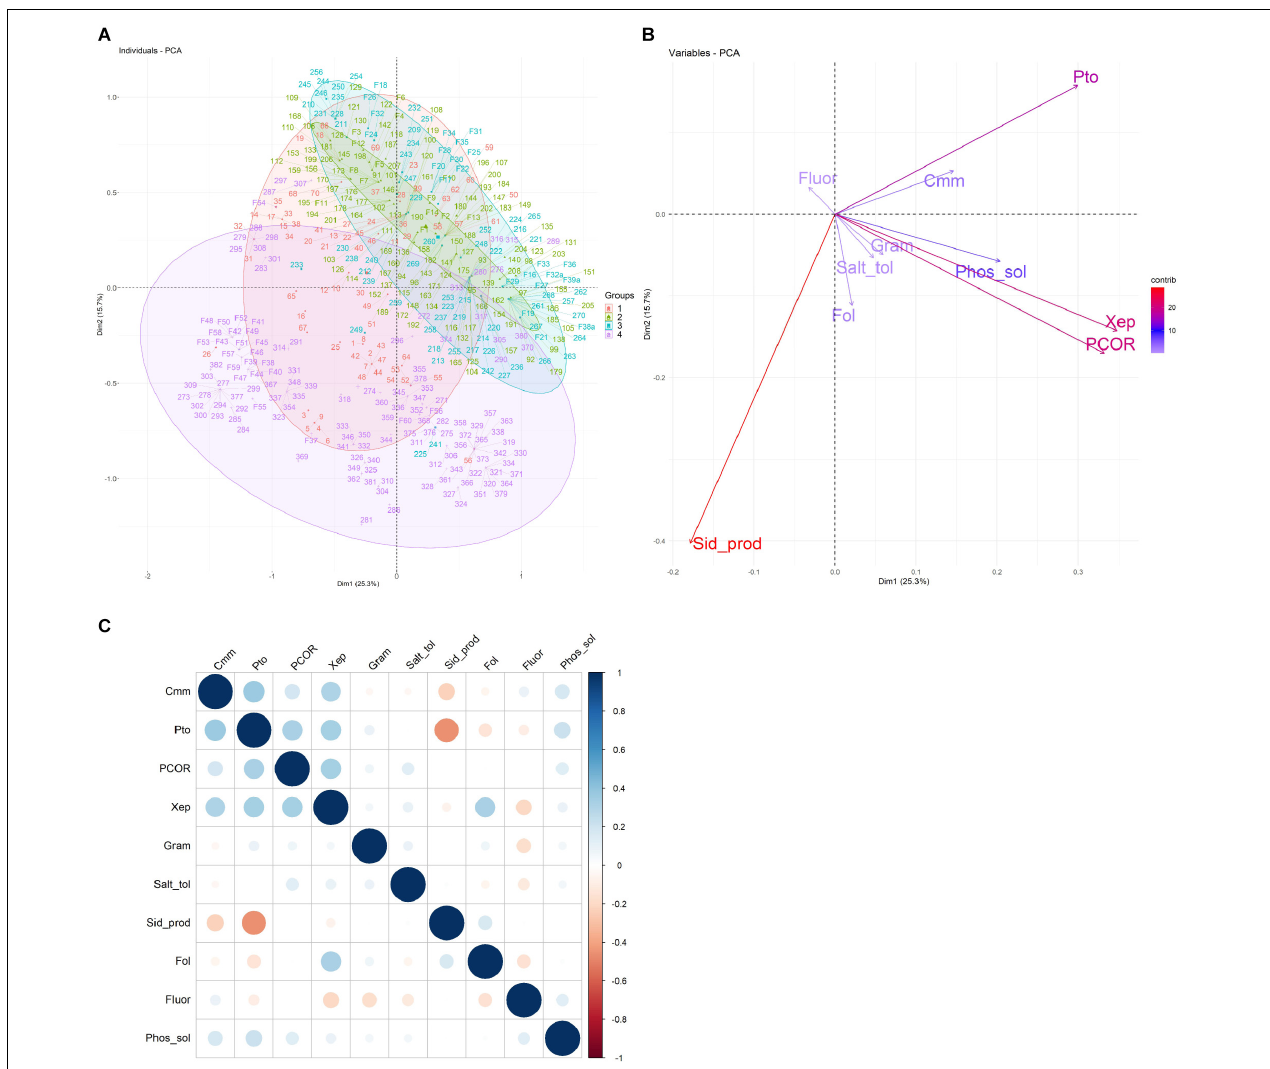
FIGURE 4 | Principal component analysis (PCA) of the characteristics related to the collection of 424 bacterial isolates. (A) The first two principal components are shown in a biplot, and bacterial isolates are colored according to the farm on which they were isolated. (B) Loading plot of the 10 traits used to compute the PCA, namely, antagonist activity against Cmm , Pco , Pto , Xep , and Fol ( Cmm , Pco , Pto , Xep , and Fol ), fluorescence on King’s medium B agar (Fluor), Gram reaction (Gram), phosphate solubilization (Phos_sol), salt tolerance (Salt_tol), and siderophore production (Sid_prod). (C) Heatmap of the pairwise correlations between the traits